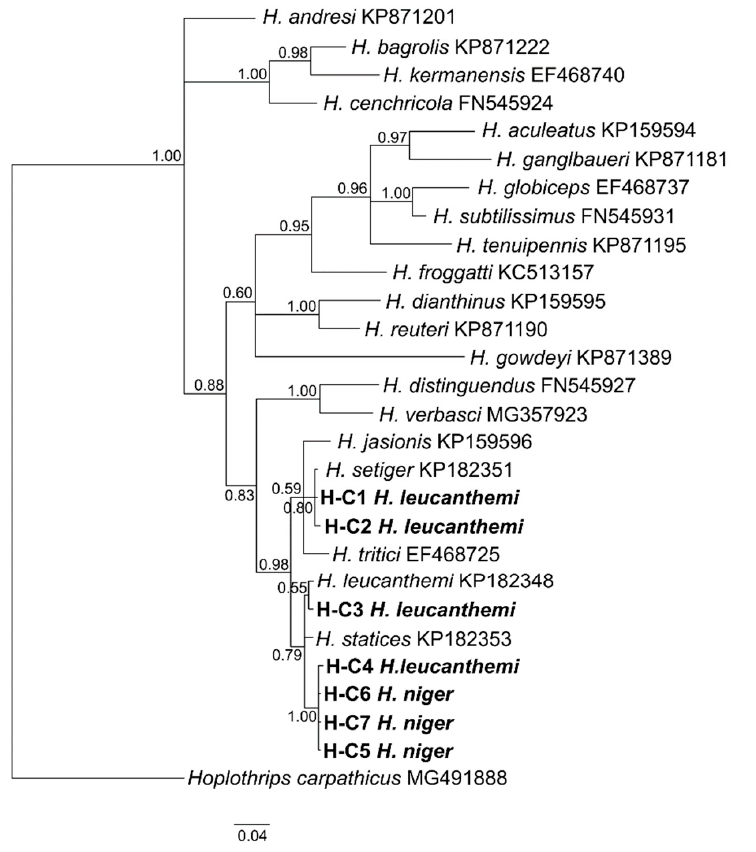
Figure 2. Bayesian dendrogram showing relationships among COI haplotypes identified in tested samples of Haplothrips leucanthemi and H. niger , and haplotypes determined for congeneric species. Posterior probability (PP) values are shown at nodes.